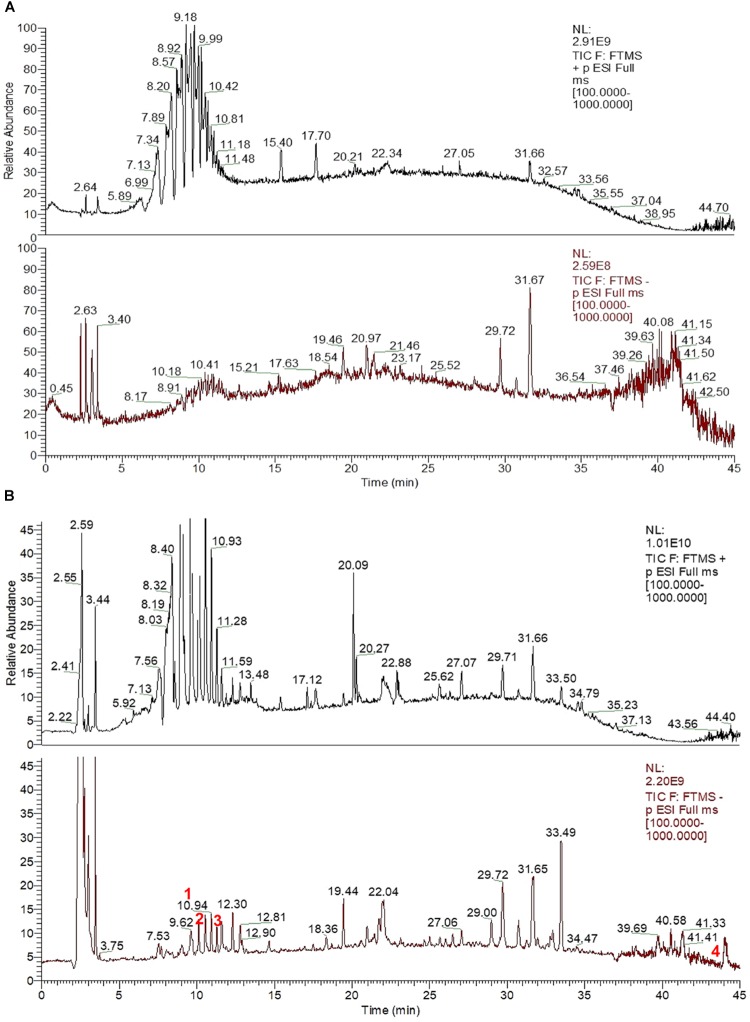
UHPLC-MS fingerprint chromatogram of CHB-II-F in blood serum [Blank serum ion map (A) and CHB-II-F-containing serum ion map of (B)].